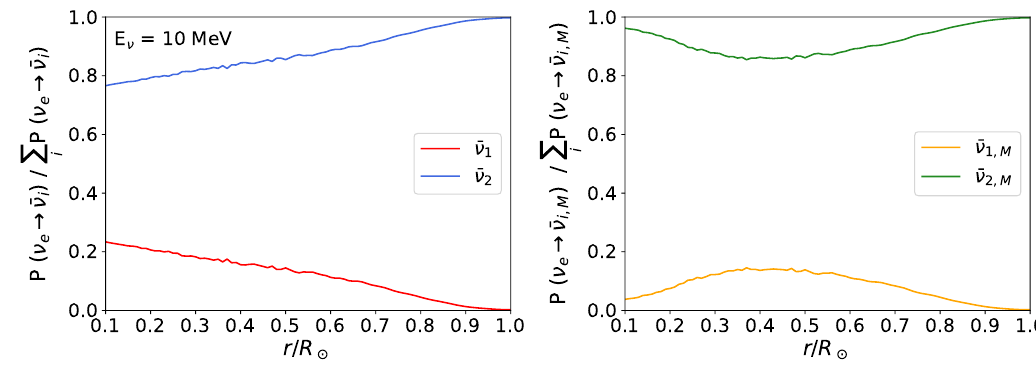
Figure 3 . Two-flavour evolution of antineutrino appearance probabilities inside the Sun for mass eigenstates (left panel) and for the matter eigenstates (right panel), normalised to the unit total antineutrino appearance probability. Assumptions regarding neutrino energy, magnetic moments and the ν e production coordinate are the same as in figure 2.